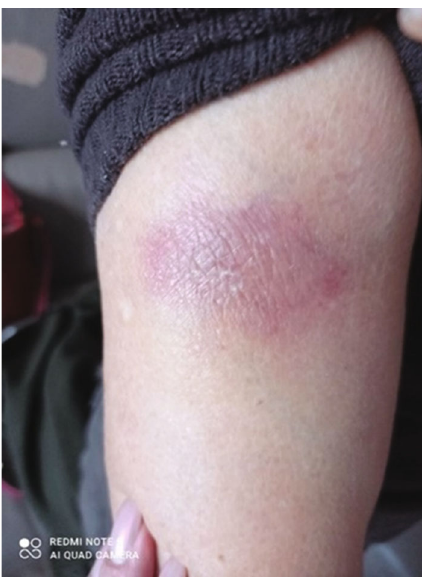
Figure 8: Skin lump 72h after Parvulan injection, which regressed spontaneously after 3